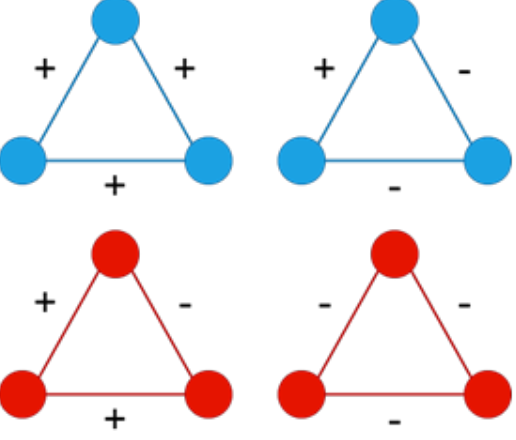
Figure 1. All possible signed triangles. The blue triangles ( above ) are balanced, while the red ones ( below ) are unbalanced.